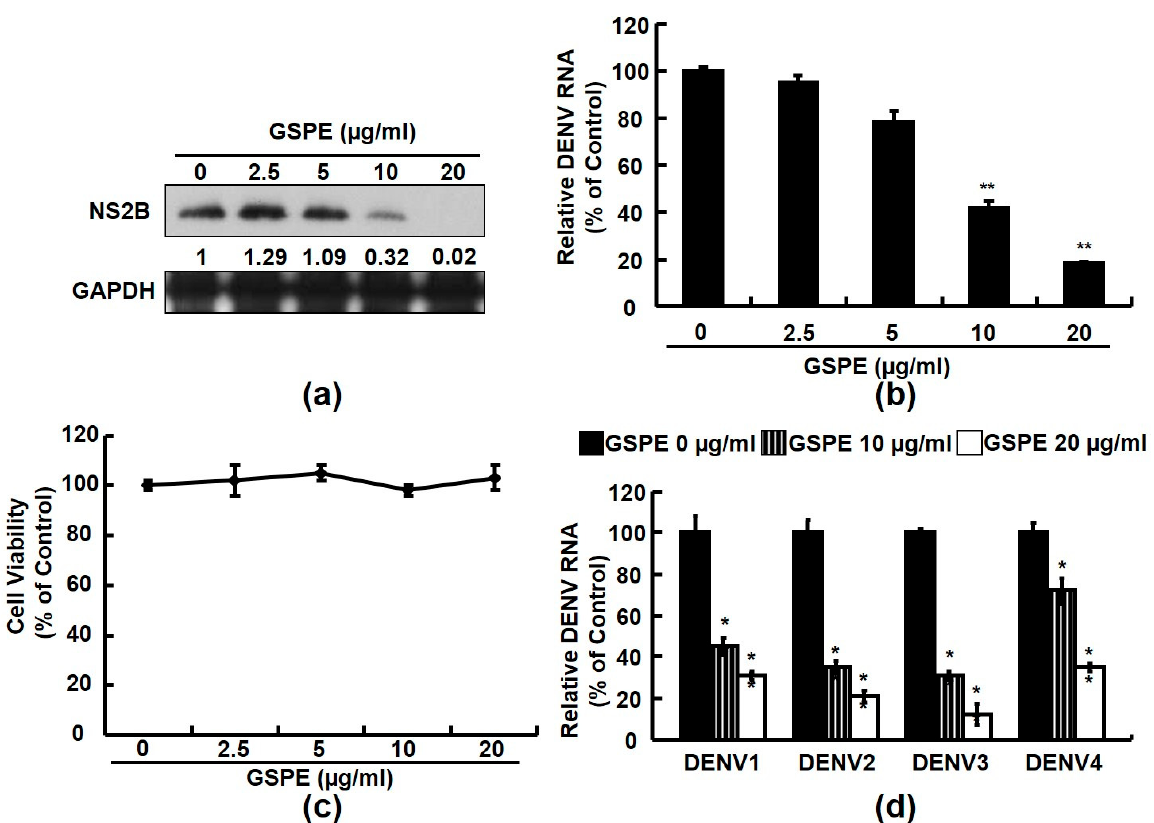
Figure 1. GSPE inhibits DENV protein synthesis and RNA replication. ( a ) DENV protein expression and ( b ) RNA replication decreased in response to the GSPE treatment in DENV-infected Huh-7 cells. Huh-7 cells were seeded in 24-well plates and infected with DENV-2 at an MOI of 0.1 for 2 h. Then, the virus was removed and the DENV-infected Huh-7 cells were treated with GSPE at increasing concentrations (2.5–20 µg/mL) for 3 days. DENV protein synthesis was detected by western blotting and RNA levels were quantified by qRT-PCR. Cellular GAPDH protein served as the equal loading control and mRNA levels served as the internal control for western blotting and RT-qPCR, respectively. The relative DENV NS2B protein levels were presented as fold-change